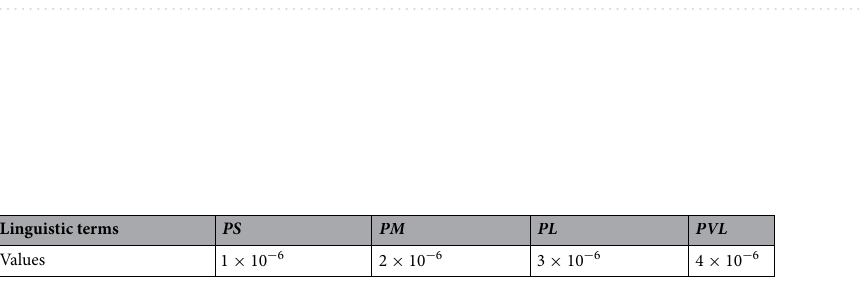
Table 2. The reference values and points of the primary term drift